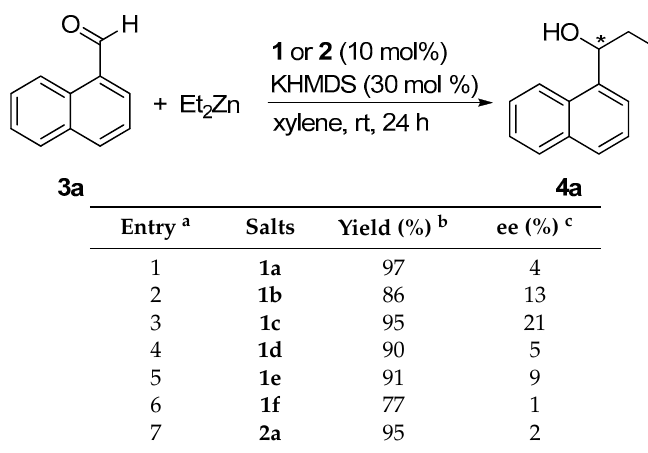
Table 1. Comparison of NHC precursors.